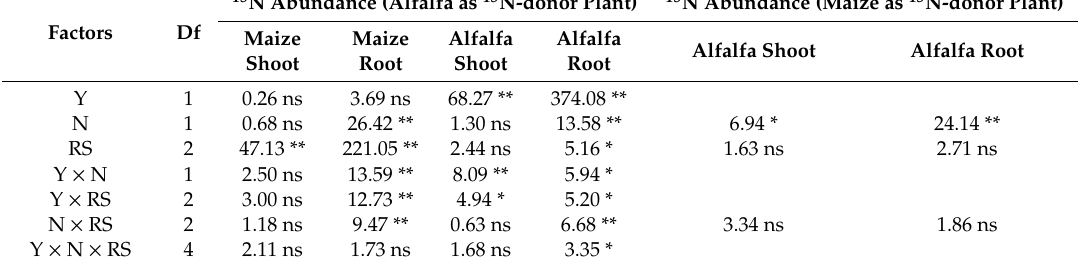
Table 3. Results of the repeated measures ANOVA for shoot and root 15 N abundance of maize and alfalfa, with nitrogen level (N) and root separation method (RS) as the independent variables and year (Y) as the repeated measure.